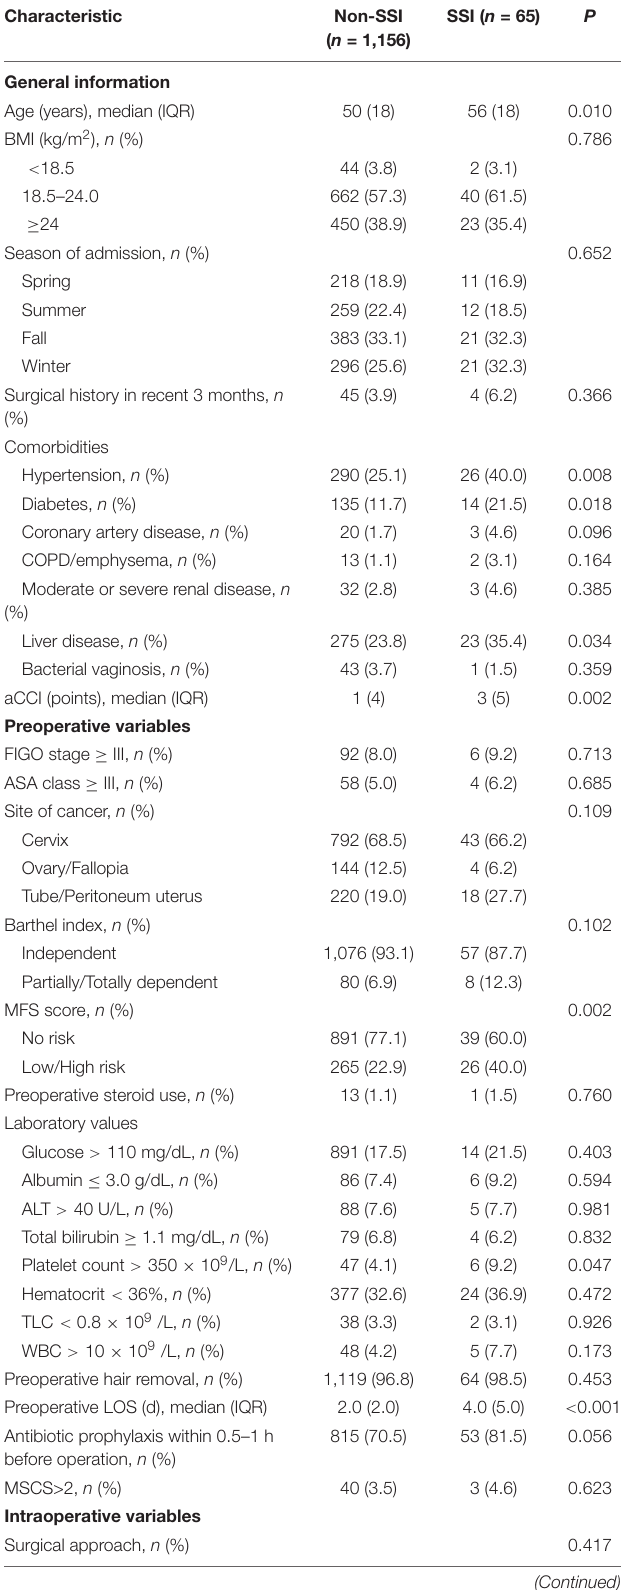
TABLE 1 | Baseline characteristics of development cohort after